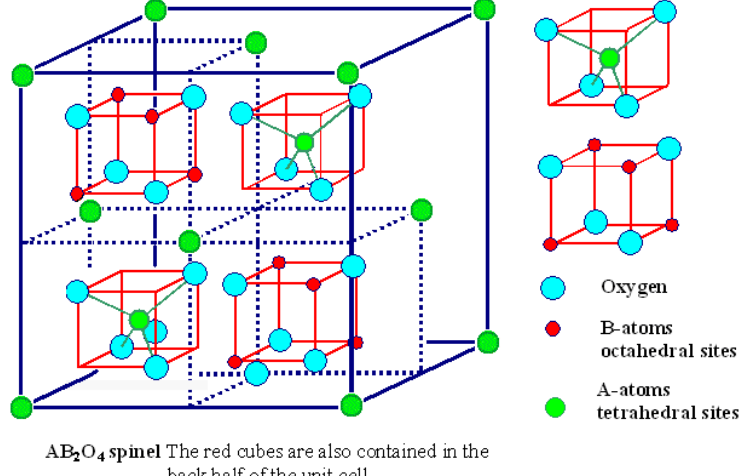
Figure 1. The spinel structure of ferrites is shown indicating the tetrahedral and octahedral sites. This figure is copied from the following website